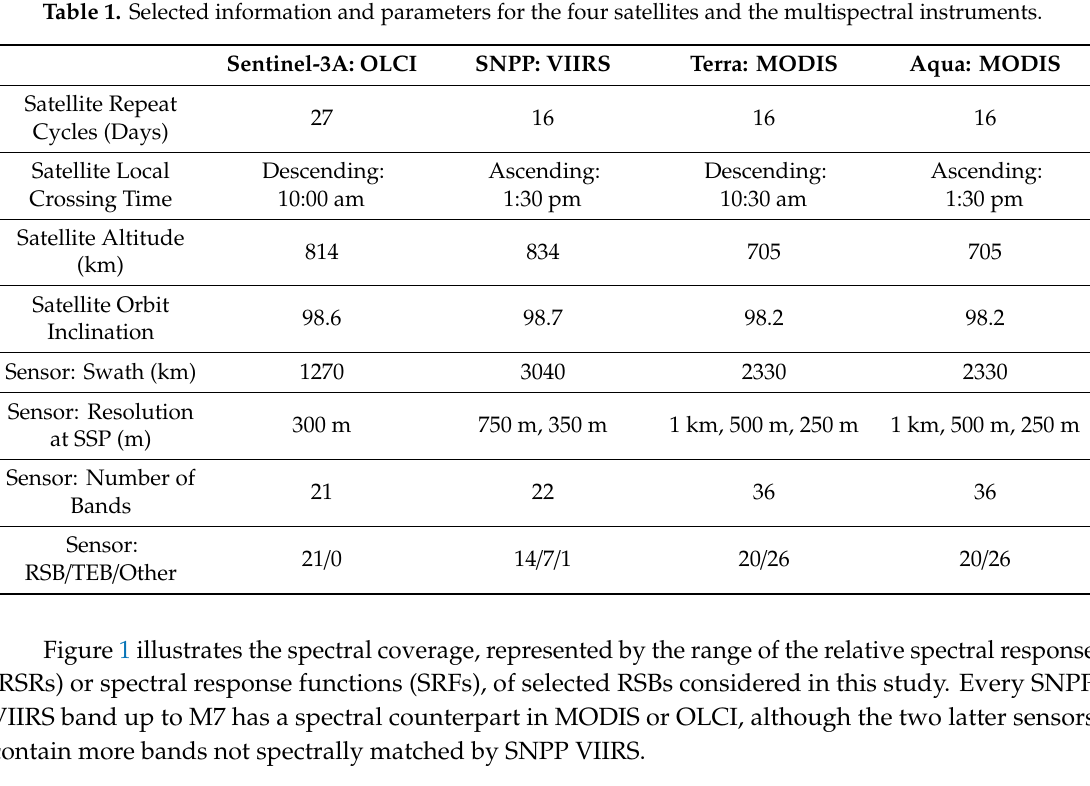
Table 1. Selected information and parameters for the four satellites and the multispectral instruments.